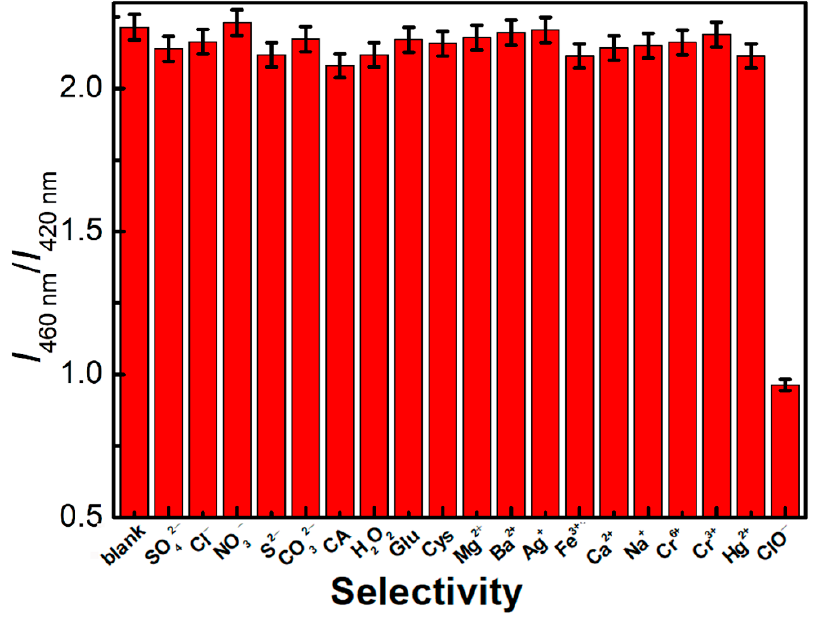
Figure 8. The selectivity of this probe in ClO − detection toward other substances. The concentrations of ClO − , SO 42 − , Cl − , NO 3 − , S 2 − , CO 32 − , Mg 2+ , Ba 2+ , Ag + , Fe 3+ , Ca 2+ , Na + , Cr 6+ , Cr 3+ , Hg + , H 2 O 2 , Glu (glutamate), Cys (cysteine), and CA (citric acid) are 50 μ M; c (probe, μ L): 20; reaction time (min): 5; temperature ( ◦ C): 25 (room temperature); 40 mM phosphate buffer solution: pH 8.0. λ ex : 285 nm; λ em : 460 nm. All error bars represent the standard deviation of the three measurements.